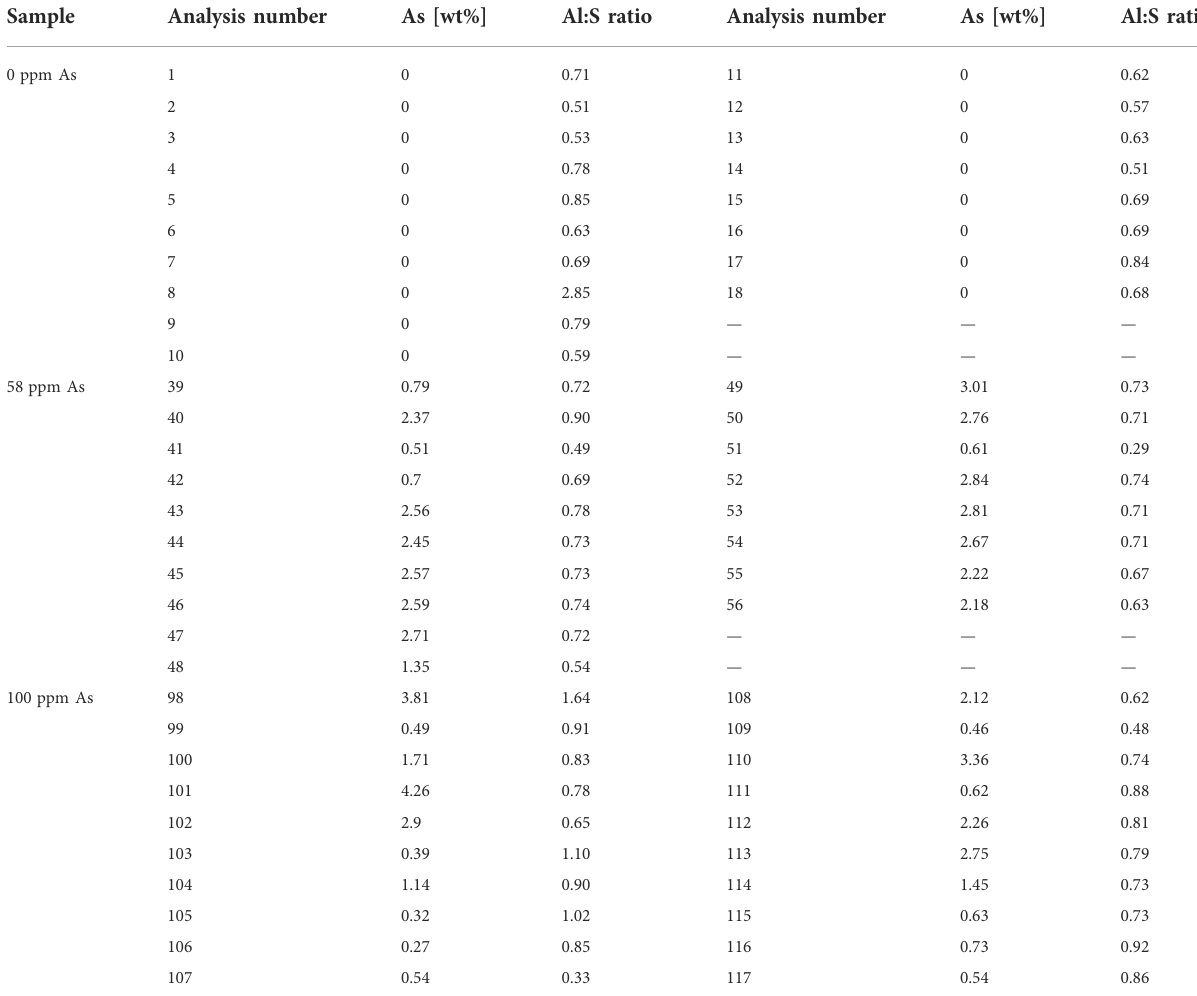
TABLE 2 Al/S ratio in the precipitates from arsenic co-precipitation